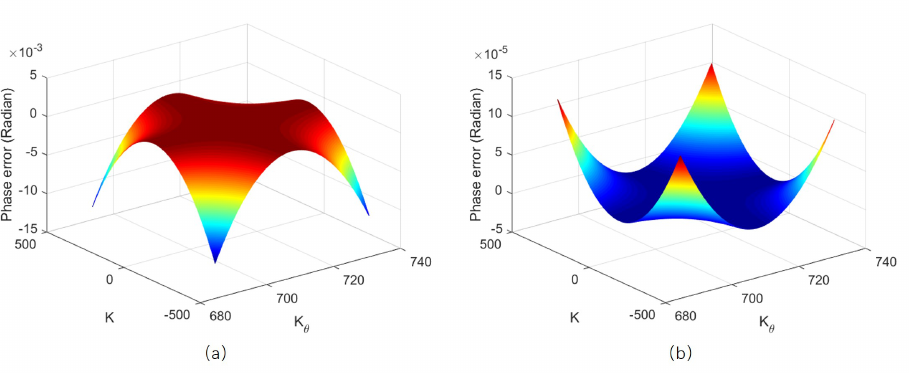
Figure 6. Phase error caused by the algorithm: ( a ) Phase error of targets at near range. ( b ) Phase error of targets at far range.